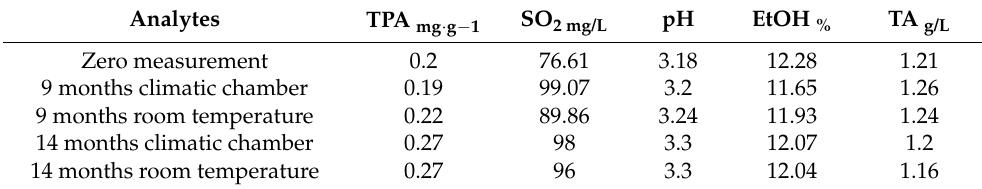
Table 6. Basic oenological parameters. Biologically active substances. Sauvignon. Basic oenolog- ical parameters . Sample A—Sauvignon, wine harvest 2016.